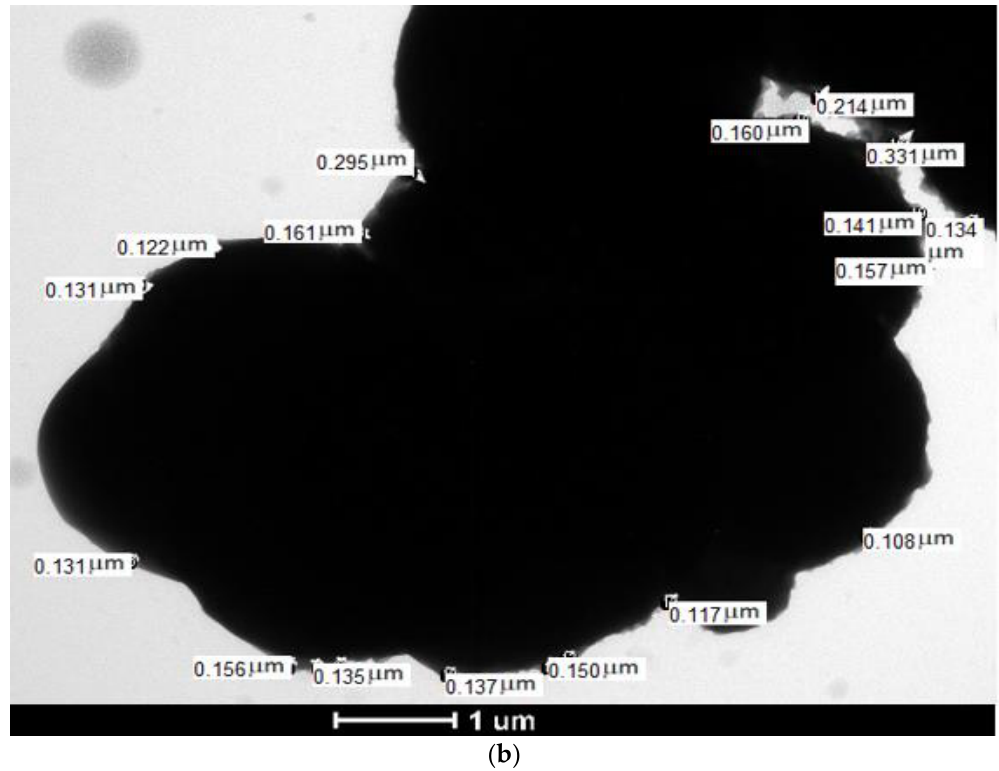
Figure 6. Trial-1 microcapsule TEM images at scales of ( a ) 500 nm and ( b ) 1µm.